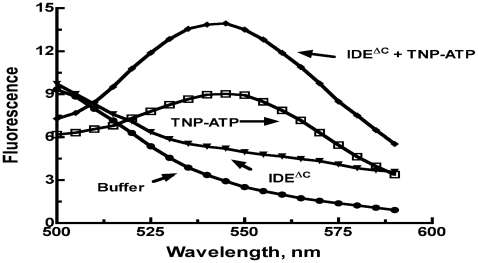
Binding of TNP-ATP to IDEΔC.Fluorescence emission spectra of 10 µM TNP-ATP in the presence or absence of 1.5 µM of IDEΔC in 50 mM Tris-HCl, pH 7.4 were recorded on a Perkin-Elmer LS 55 Luminescence spectrometer. Fluorescence spectra were recorded with a λexc = 403 nm.